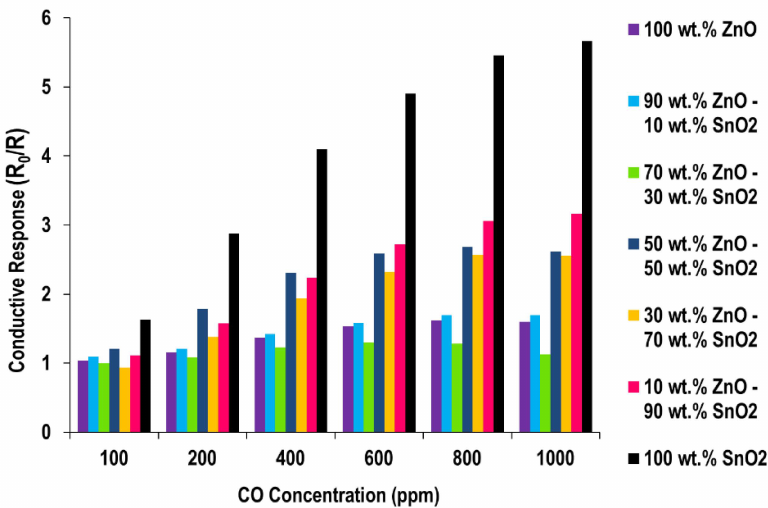
Figure 11. Conductive responses of SnO 2 -ZnO array towards 100, 200, 400, 600, 800 and 1000 ppm CO gas, at an operating temperature of 300 ˝ C. The best response of 5.9 is observed for the 100 wt% SnO 2 device towards 1000 ppm of